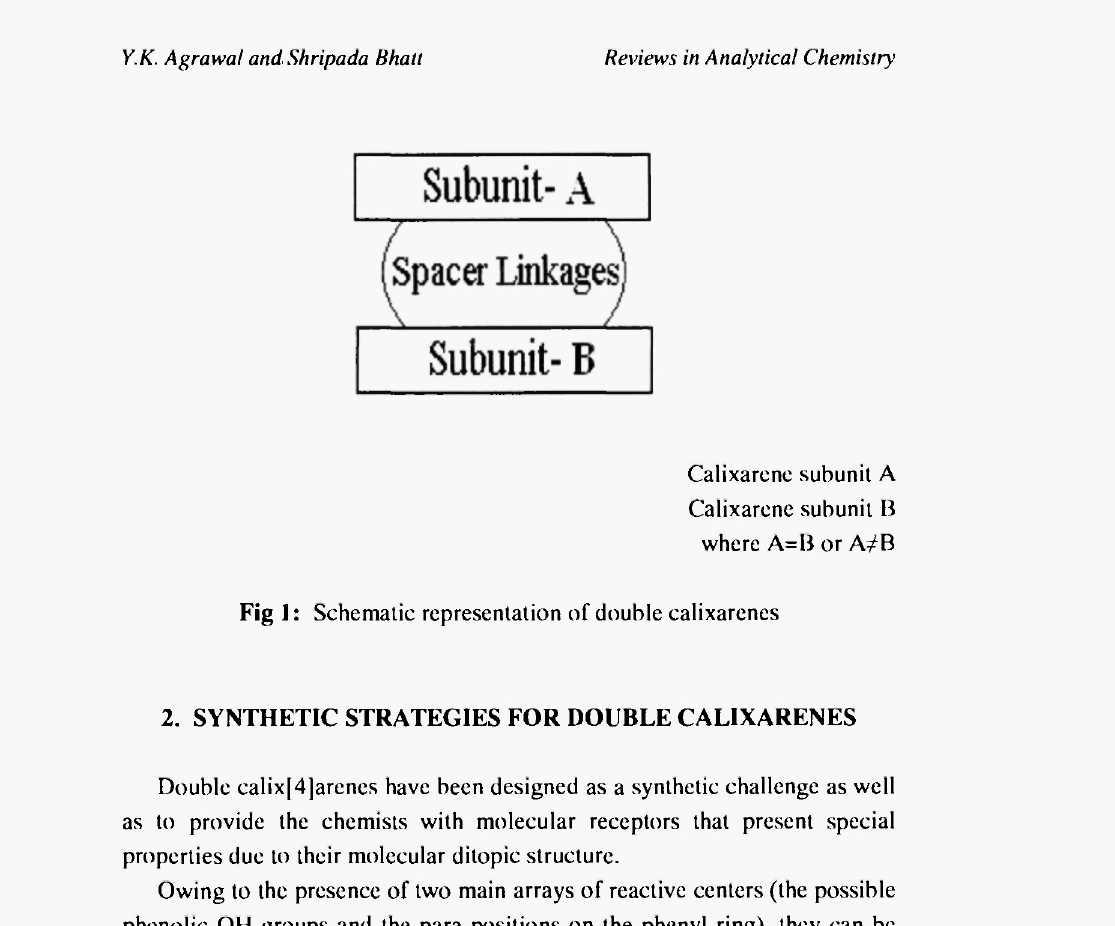
Fig 1 : Schematic representation of double